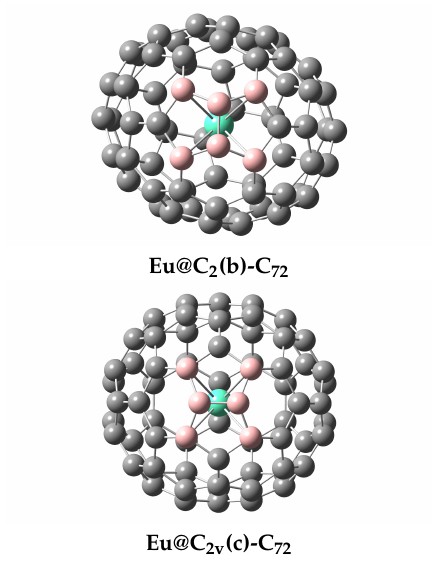
Figure 1. The B3LYP/6-311G* ∼ SDD optimized structures of (b) and (c) Eu@C 72 (the carbons closest to Eu are in a lighter color and with the C-Eu